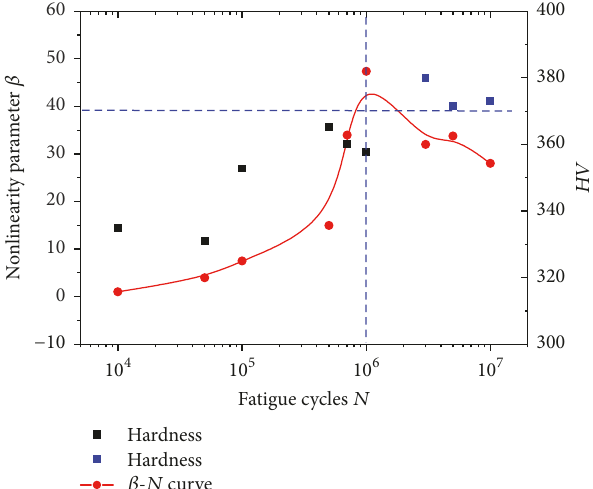
Figure 17: Relationship between hardness and nonlinearity param- eter of KMN-I bending fatigue